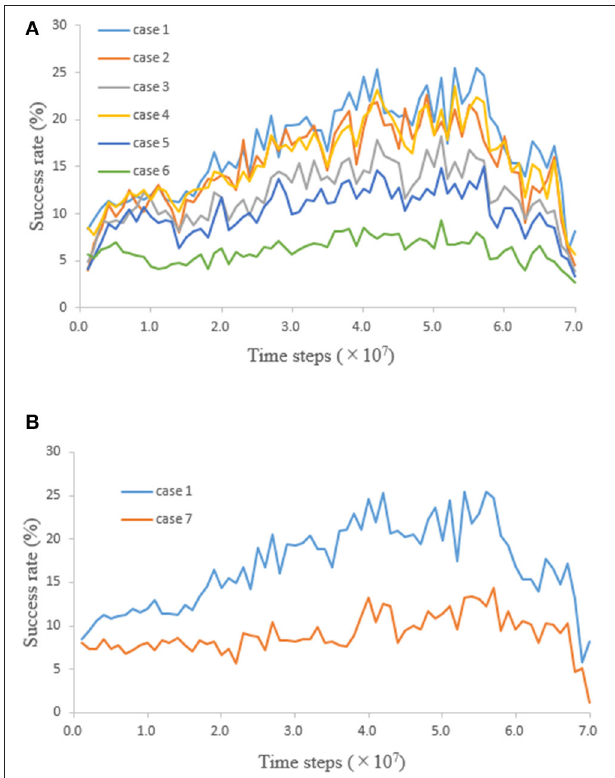
FIGURE 4 | Time series of success rate obtained by testing the network. (A) When “other” moved some squares in the field of view, the input unit corresponding to the square where “other” stayed received a visual input value. Visual input value of “other” and number of “others” were 0.2 and 1 (case 1), 0.2 and 5 (case 2), 0.2 and 20 (case 3), 0.5 and 1 (case 4), 0.5 and 5 (case 5), and 0.5 and 20 (case 6). Visual input values of “other” in cases 1, 2, and 3 were equal to the visual input value of “other” in the training phase (i.e., 0.2). Visual input values of “other” in cases 4, 5, and 6 were equal to those of the right and left “hands” (i.e., 0.5). (B) Comparison of success rates in case 1 and